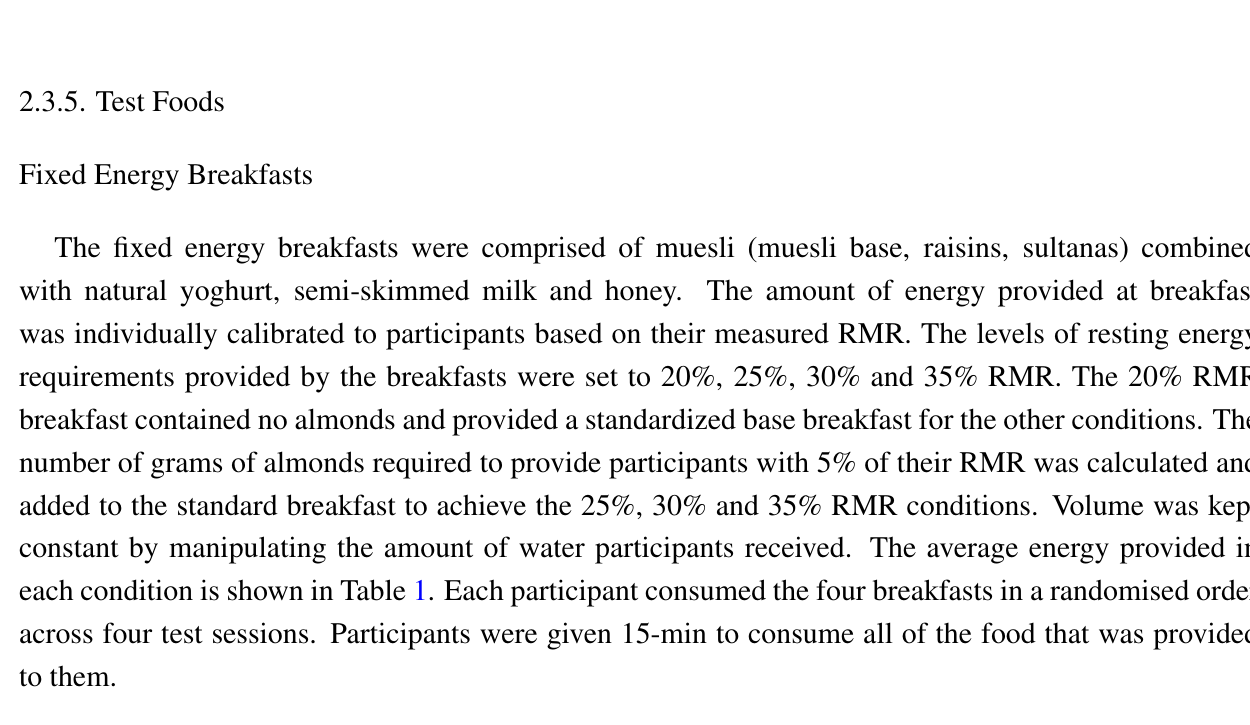
Table 1. Mean (standard deviation) and range energy (kcal) provided in the 20%, 25%, 30% and 35% resting metabolic rate (RMR)